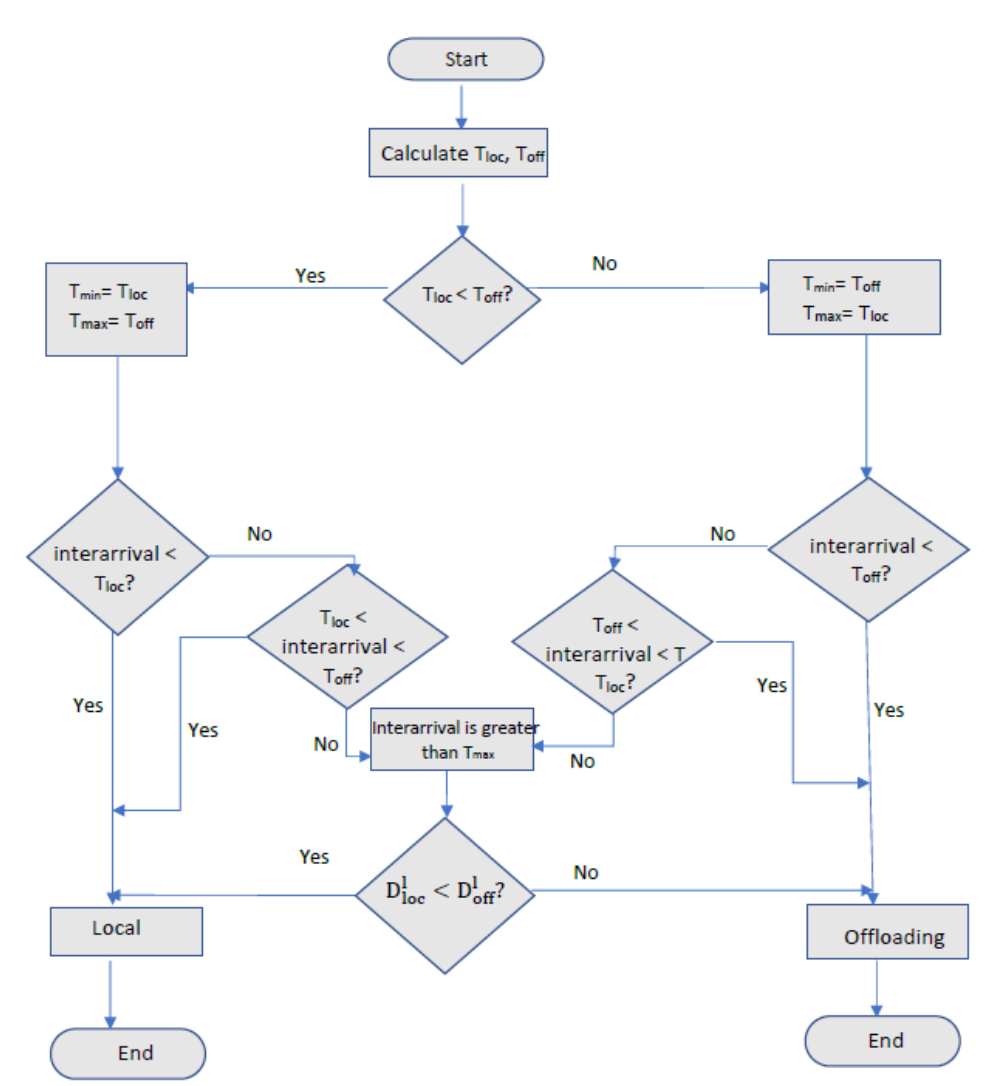
Figure 3. Flowchart of the